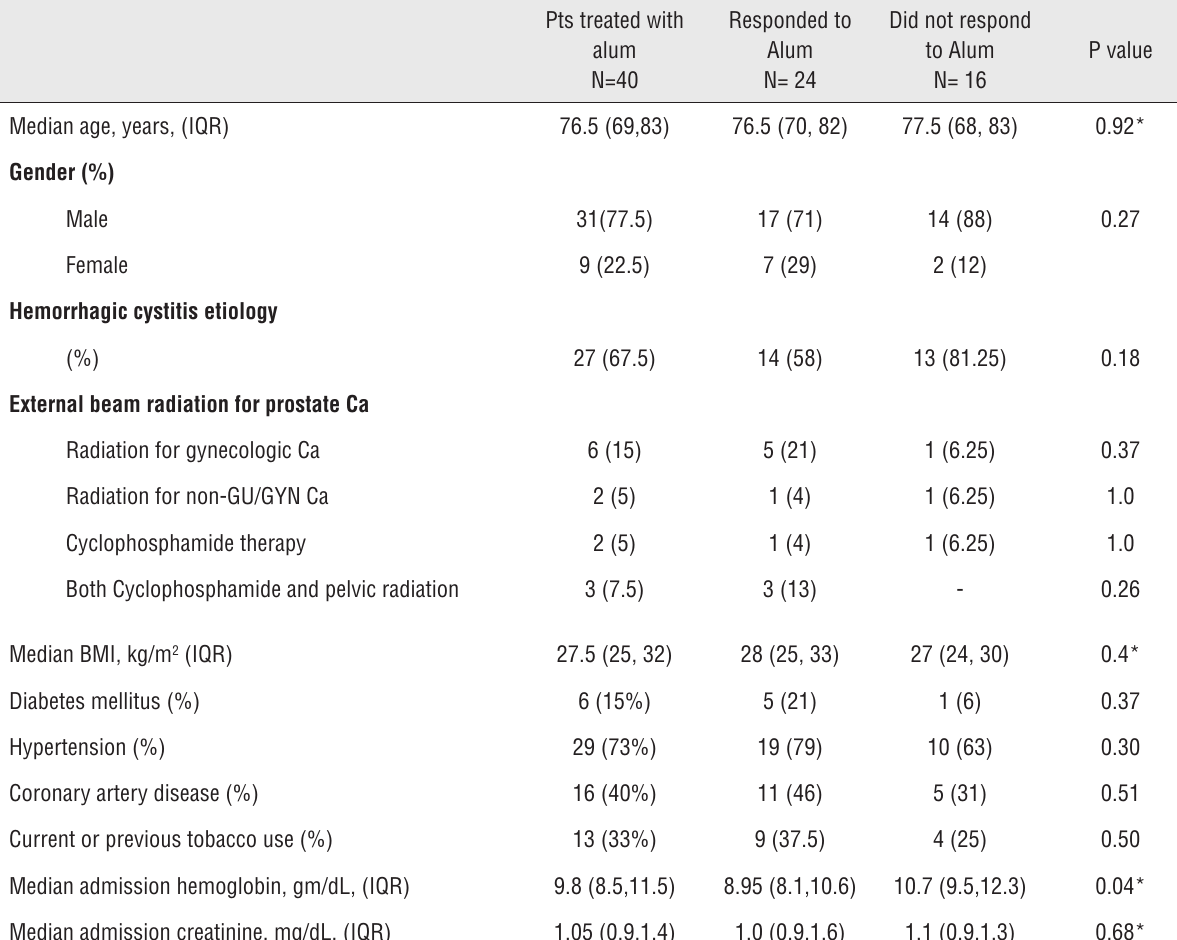
Table 1 - patient